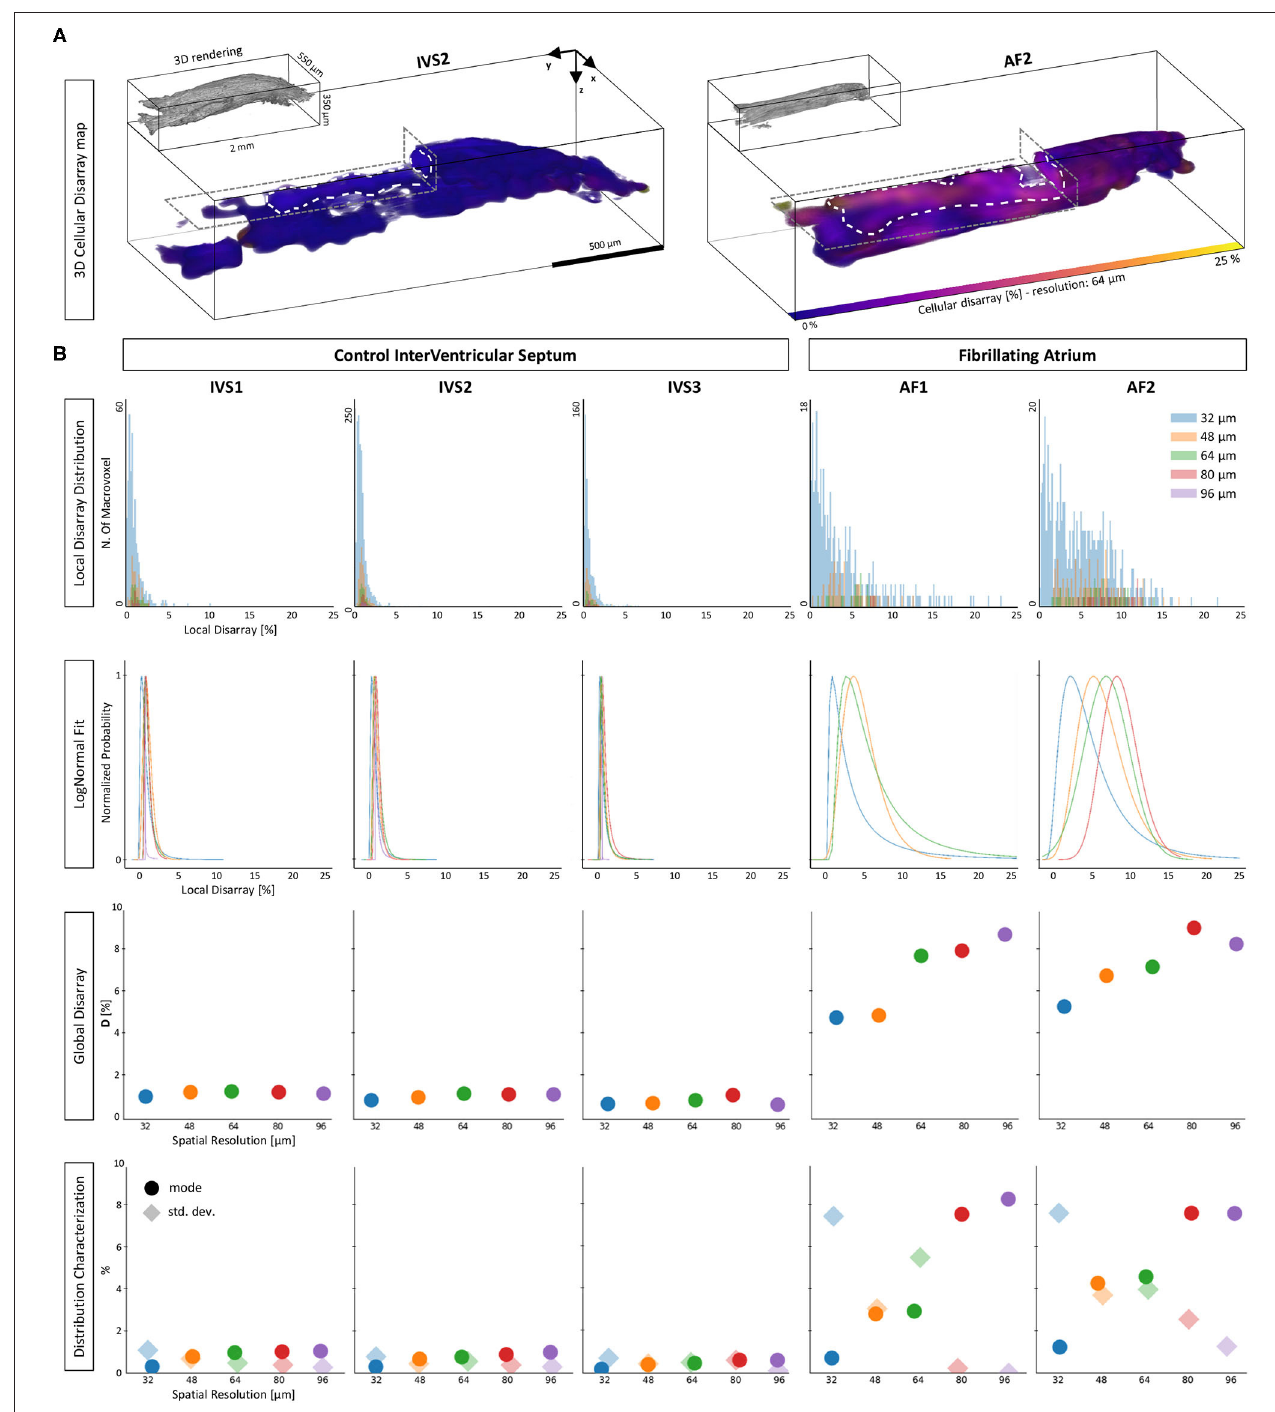
FIGURE 8 | Disarray characterization in control and pathological samples. (A) Two representative tissue disarray maps of a control (IVS2) and a pathological (AF2) cardiac tissue strip are evaluated with a spatial resolution of 32 µ m. A virtual cut (gray dashed lines) is applied to both maps to show internal sections (white dashed lines). Maps show clear differences between healthy and pathological tissue. (B) Results of a multi-resolution cellular disarray investigation applied on three septum tissue strips (IVS1, IVS2, and IVS3) and two fibrillating atrium tissue strips (AF1 and AF2) strips are shown. The raw distributions of the local disarray values are shown. A log-normal PDF is used to fit disarray distributions, and results are normalized separately for each spatial resolution. Global statistics are shown as Global Disarray ( D ), mode, and SD of the distributions.